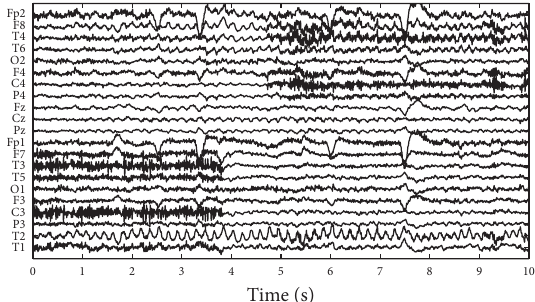
Figure 3: The original ictal 10-second scalp EEG